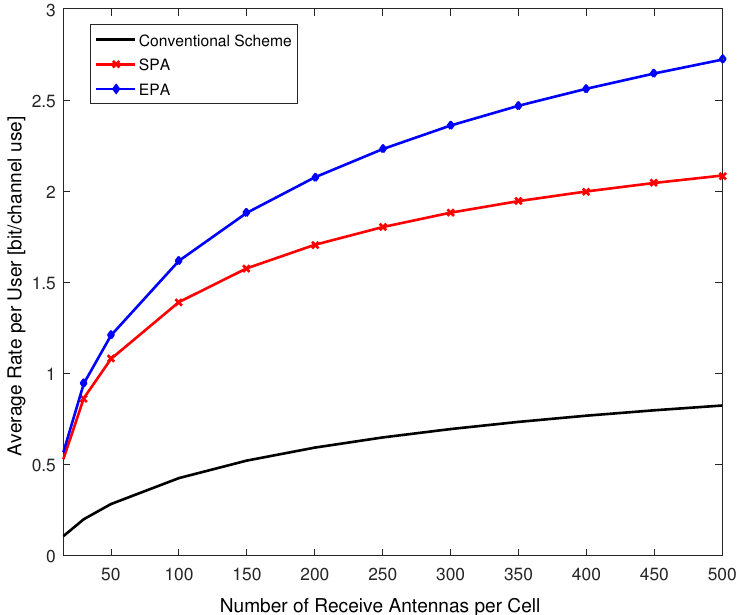
Figure 4. The average uplink rate per user with maximum ratio combining (MRC) for different numbers of